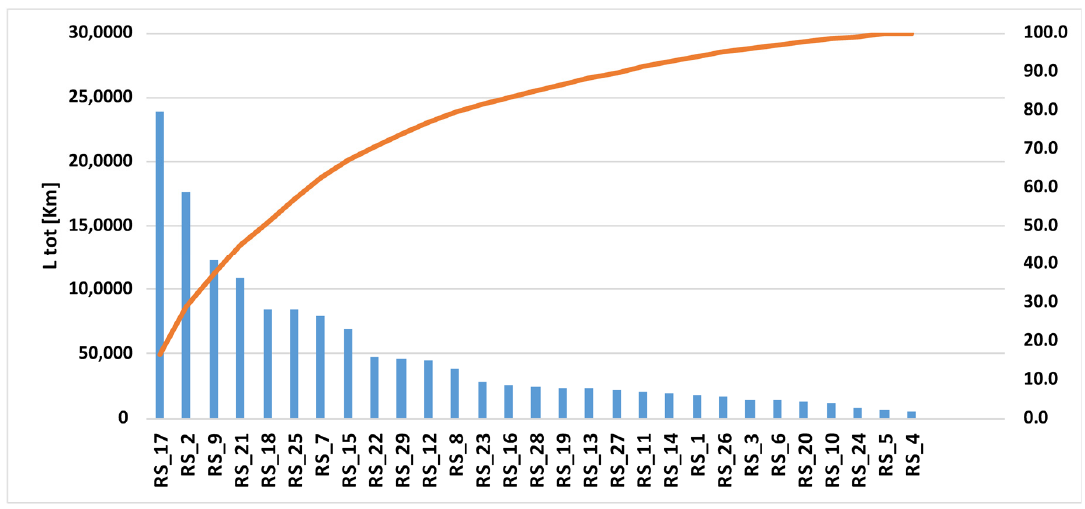
Figure 10. Distribution of River Styles of the Magdalena River based on their total length of occurrence (L tot). RS meaning is synthetically explained in Table 1. Table 2. Occurrence (% of river length excluding Betania reservoir) of values of RS attributes adopted for the Magdalena River. The attribute “islands” is the output of the reductionist-holistic algorithm applied with a significant length of 5 km (the 100 indicates the summation of the single % values).